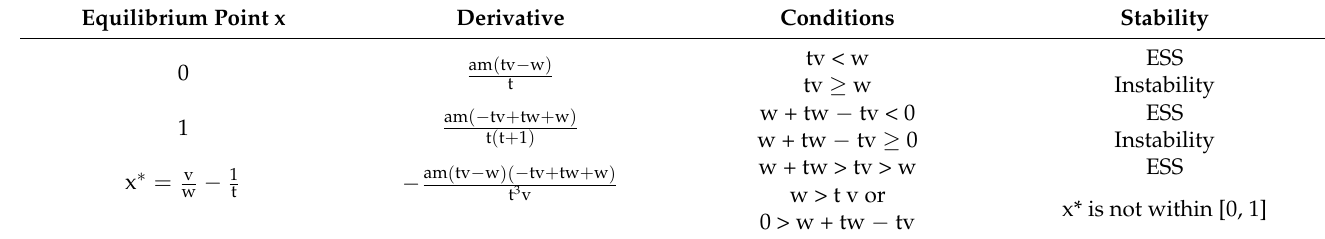
Table 5. Stability table of EV producer.